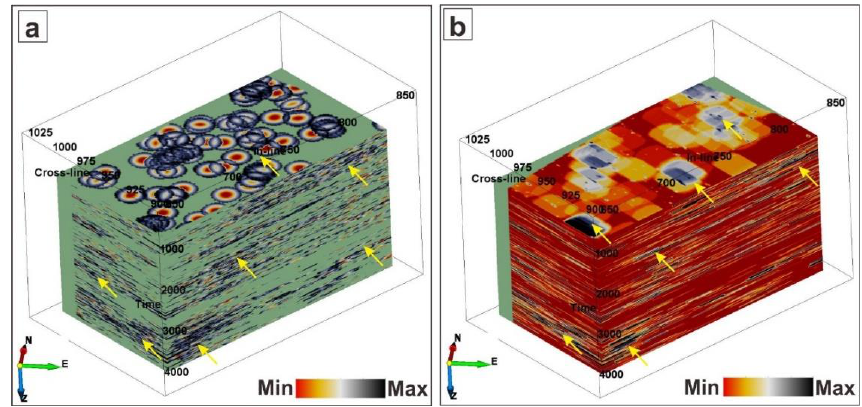
Figure 10. ( a ) Fracture proximity cube; ( b ) fracture density attribute cube. The yellow arrows show the regions of maximum fracture activity.